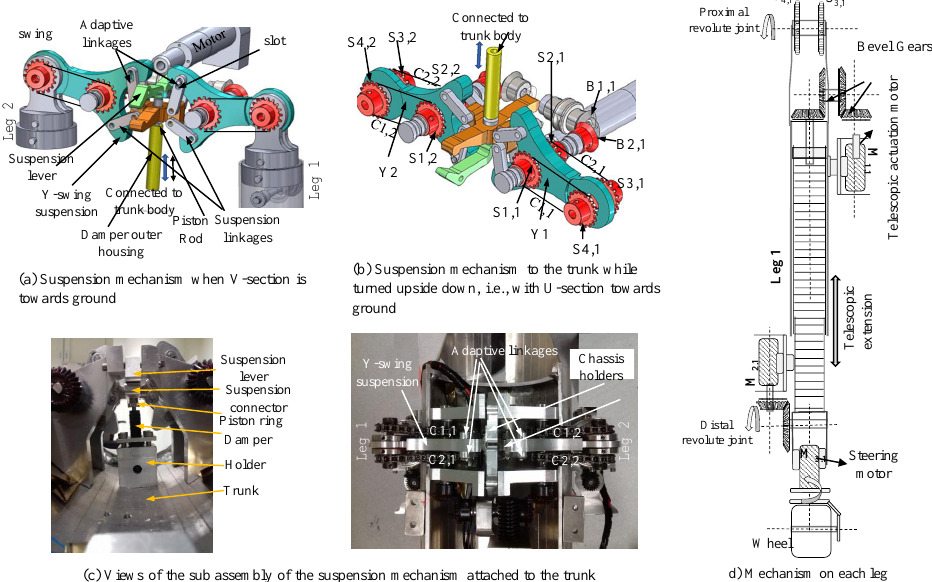
Figure 5. Suspension system that provides depression and elevation at the proximal revolute